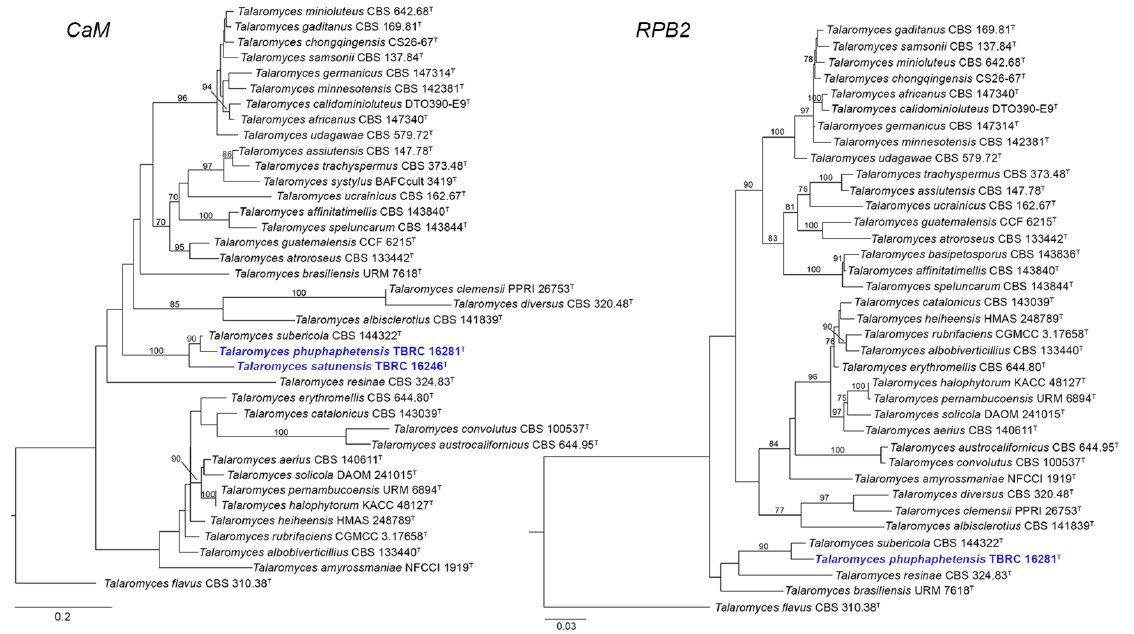
Figure 2. Maximum likelihood phylogeny based on the CaM ( left ) and RPB2 genes ( right ) for the closely related species belonging to Talaromyces section Trachyspermi . Talaromyces flavus (CBS 310.38) was chosen as the outgroup. New species are indicated in blue. T = Ex-type strain. Bootstrap (BS) values ≥ 70% are indicated at the nodes.